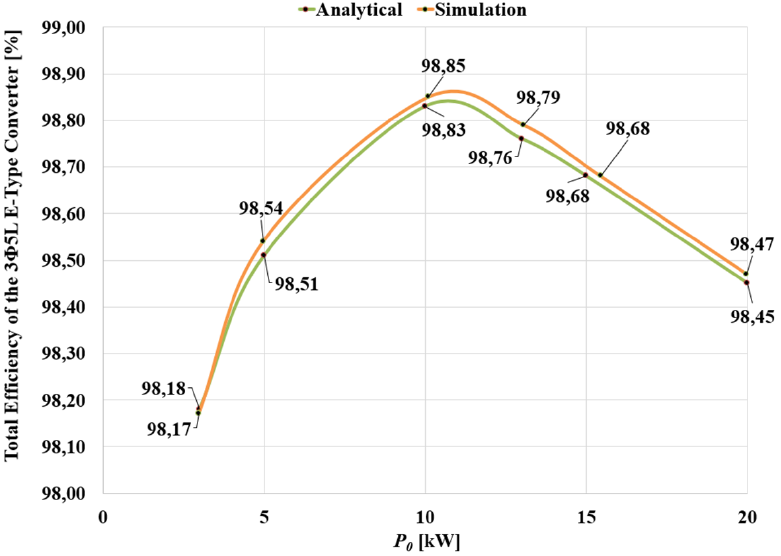
Figure 14. Total efficiency of the 3 Φ 5L E-Type MMC as a function of the power P 0 : analytical result (green line), simulation result (orange line). Table 2. Operating parameters of the 3 Φ 5L E-Type MMR and MMI.